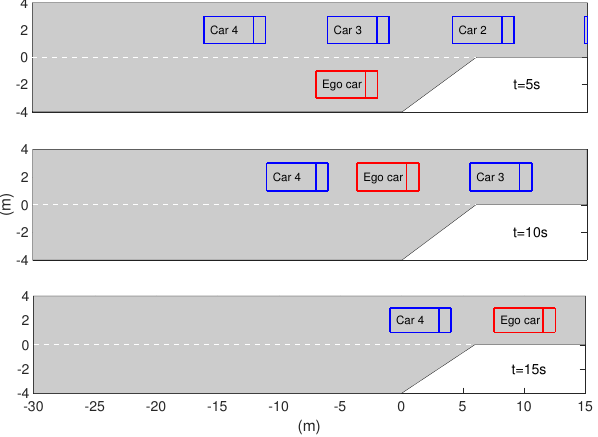
Figure 5. Scenario 1: p i = { 0.9,0.1,0.9,0.9 } .